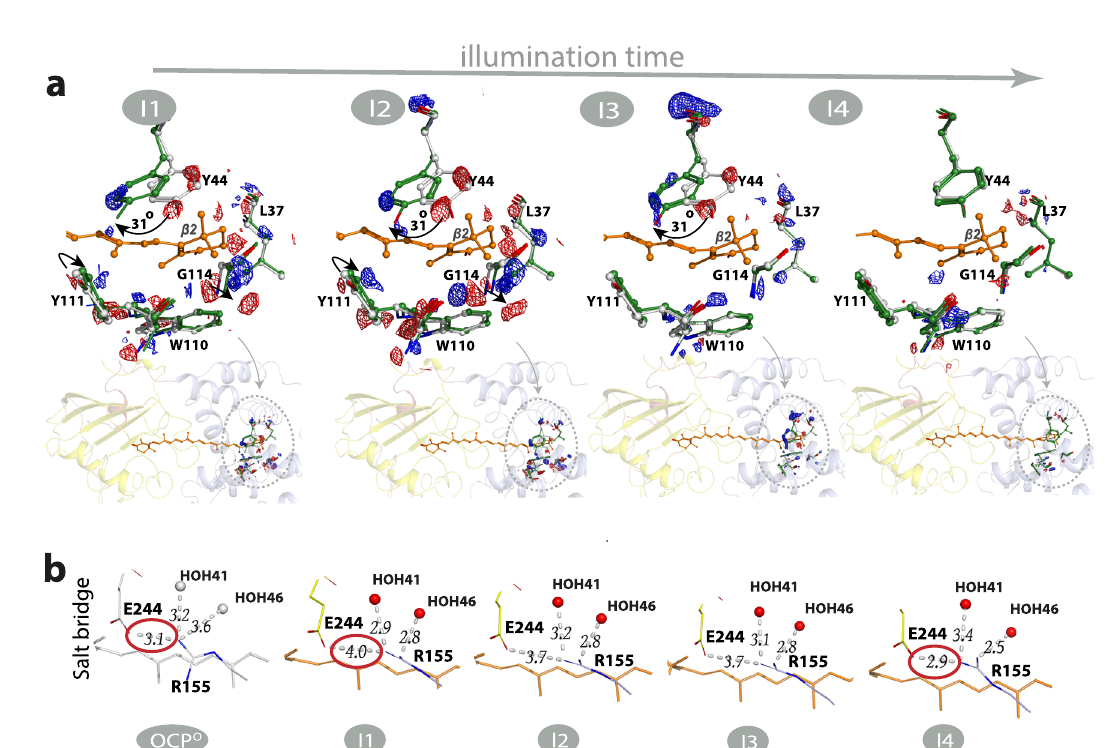
Fig. 6 | OCP structuralchanges inI1 – I4states uponillumination.a Dark (OCP O ) coordinates are represented by grey sticks while light state coordinates obtained from extrapolated maps (I1 – I4) are represented by green (NTD) and orange (CAN)